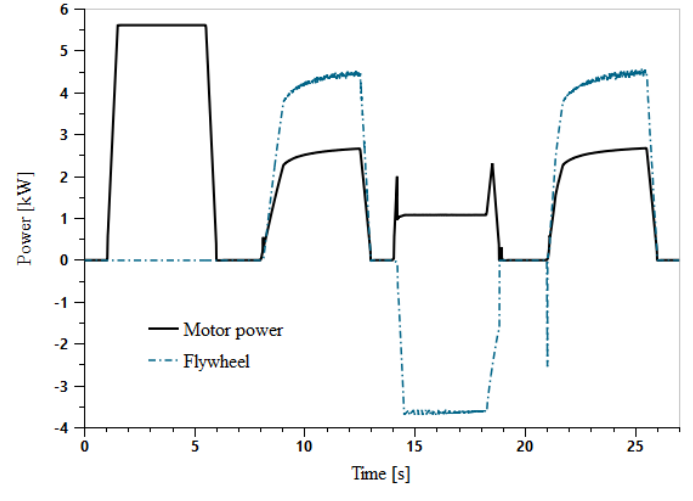
Figure 16. Power curves of the motor and flywheel when the excavator bucket is empty.